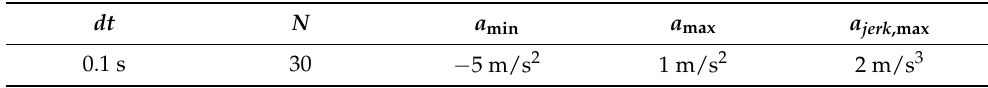
Table 2. Parameters for target state decision for approach